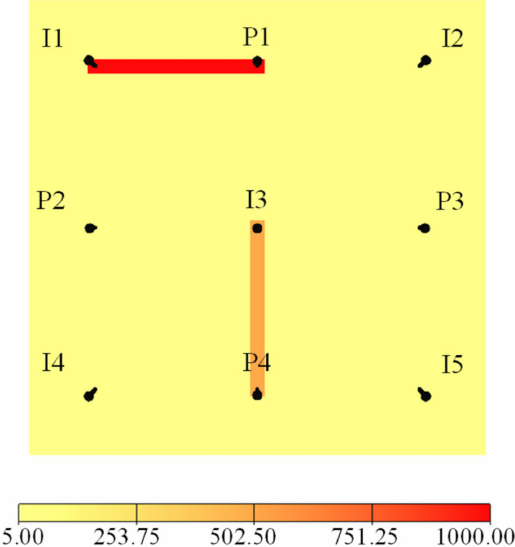
Figure 5. Permeability field of the streak reservoir case.